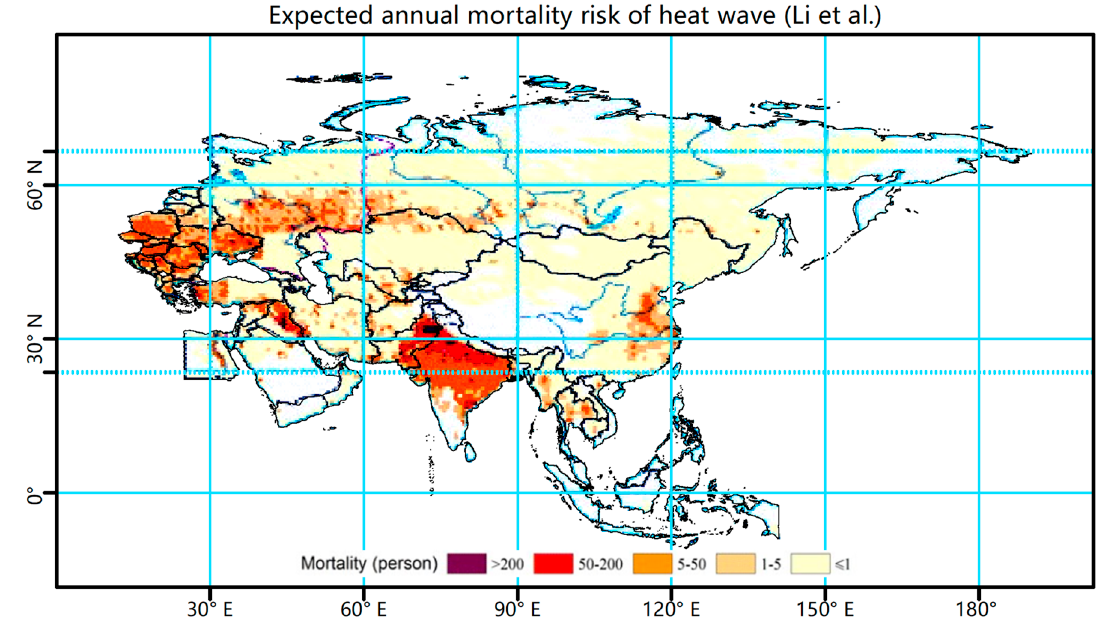
Figure 11. Heat wave risk assessment (Li et al.).